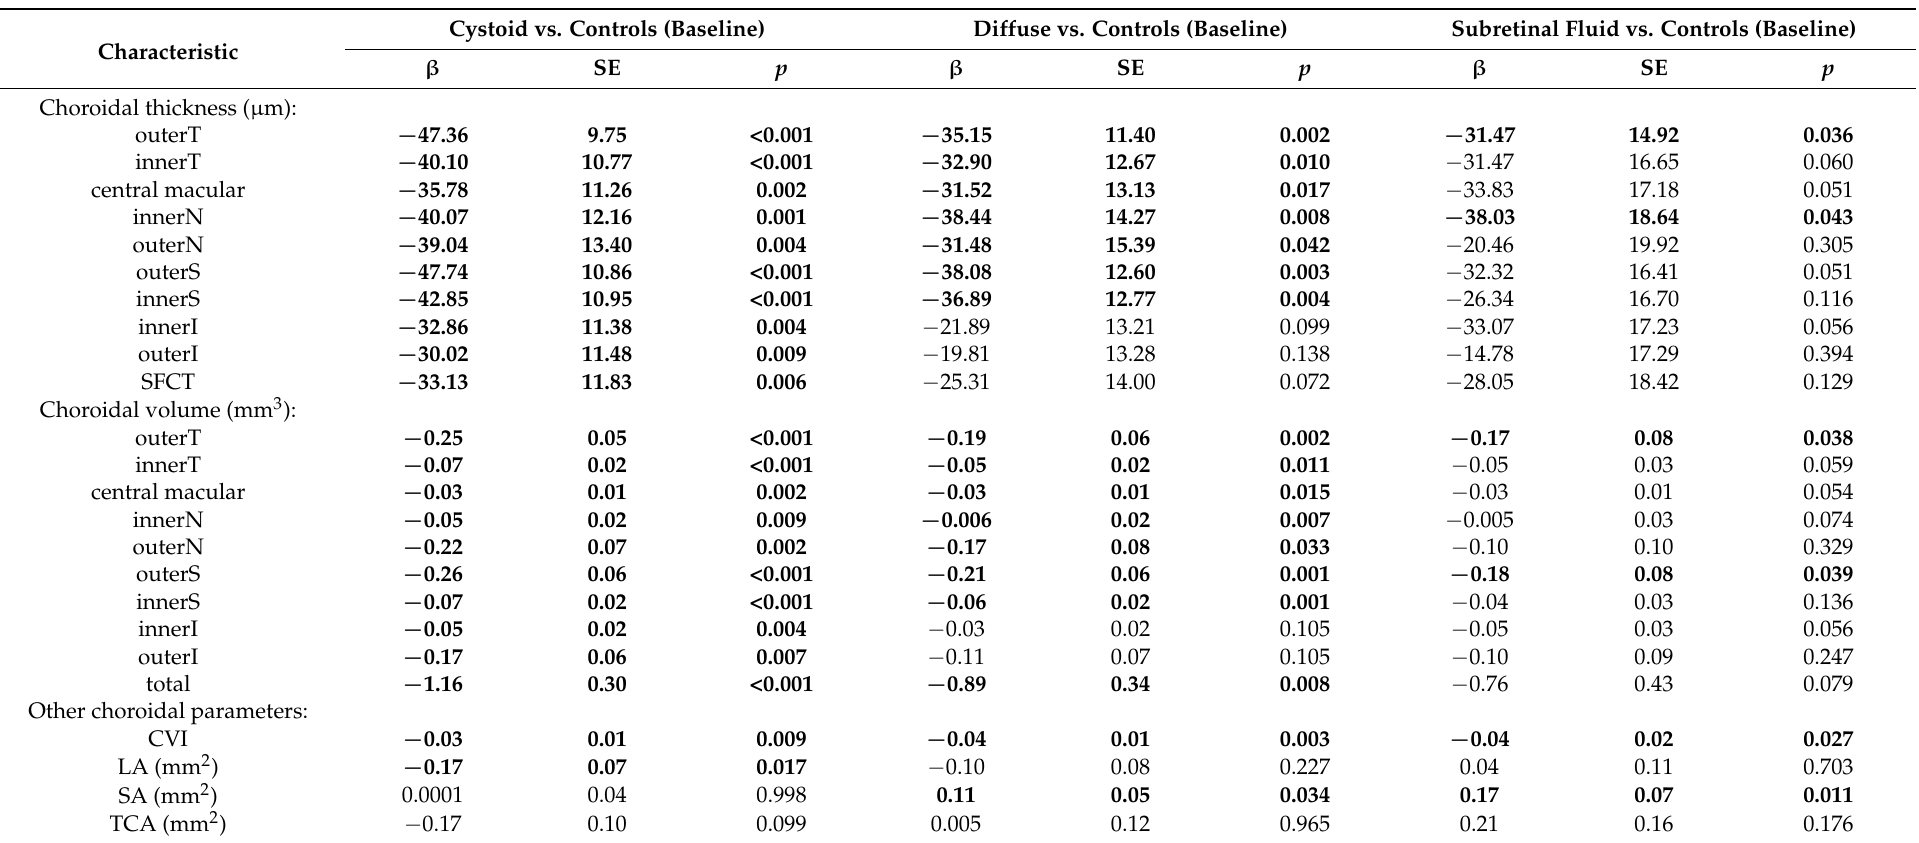
Table 2. Univariate mixed-effect models (with covariates) comparing the study groups identified based on the type of DME (cystoid/diffuse/subretinal fluid) with non-diabetic controls. Cystoid vs. Controls (Baseline) Diffuse vs. Controls Characteristic